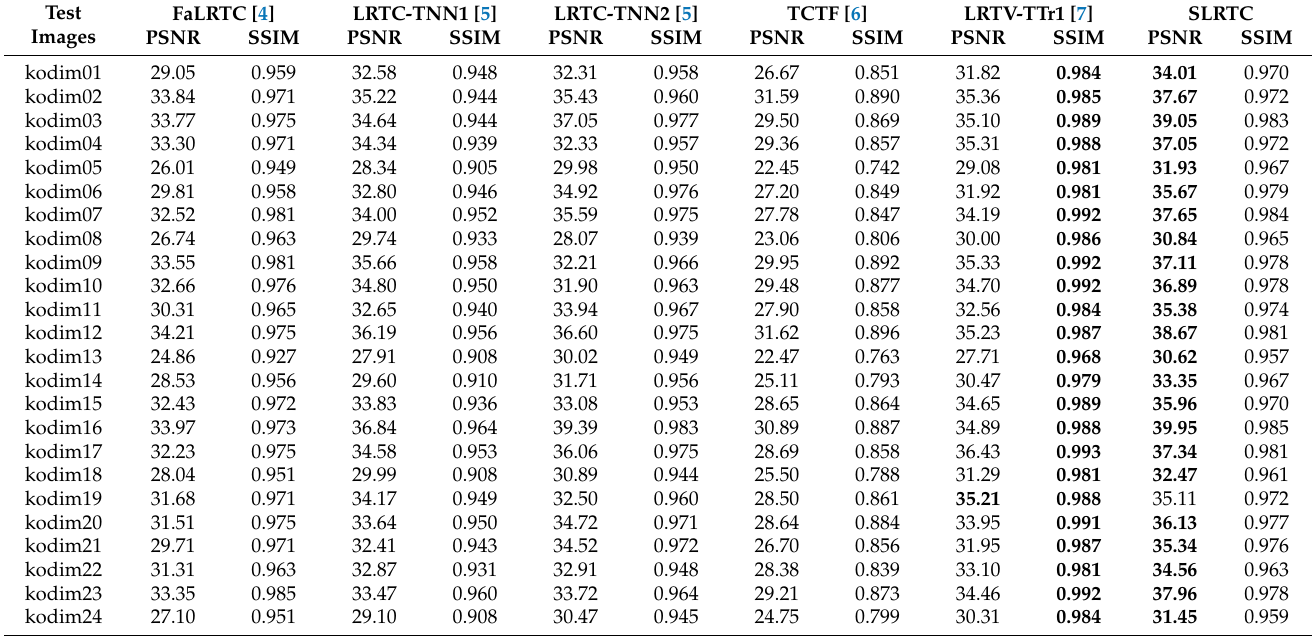
Table 3. The PSNR and SSIM Comparison of different methods on the Kodak PhotoCD dataset, the incomplete images tested contain 50 percent missing entries (The best results are highlighted).